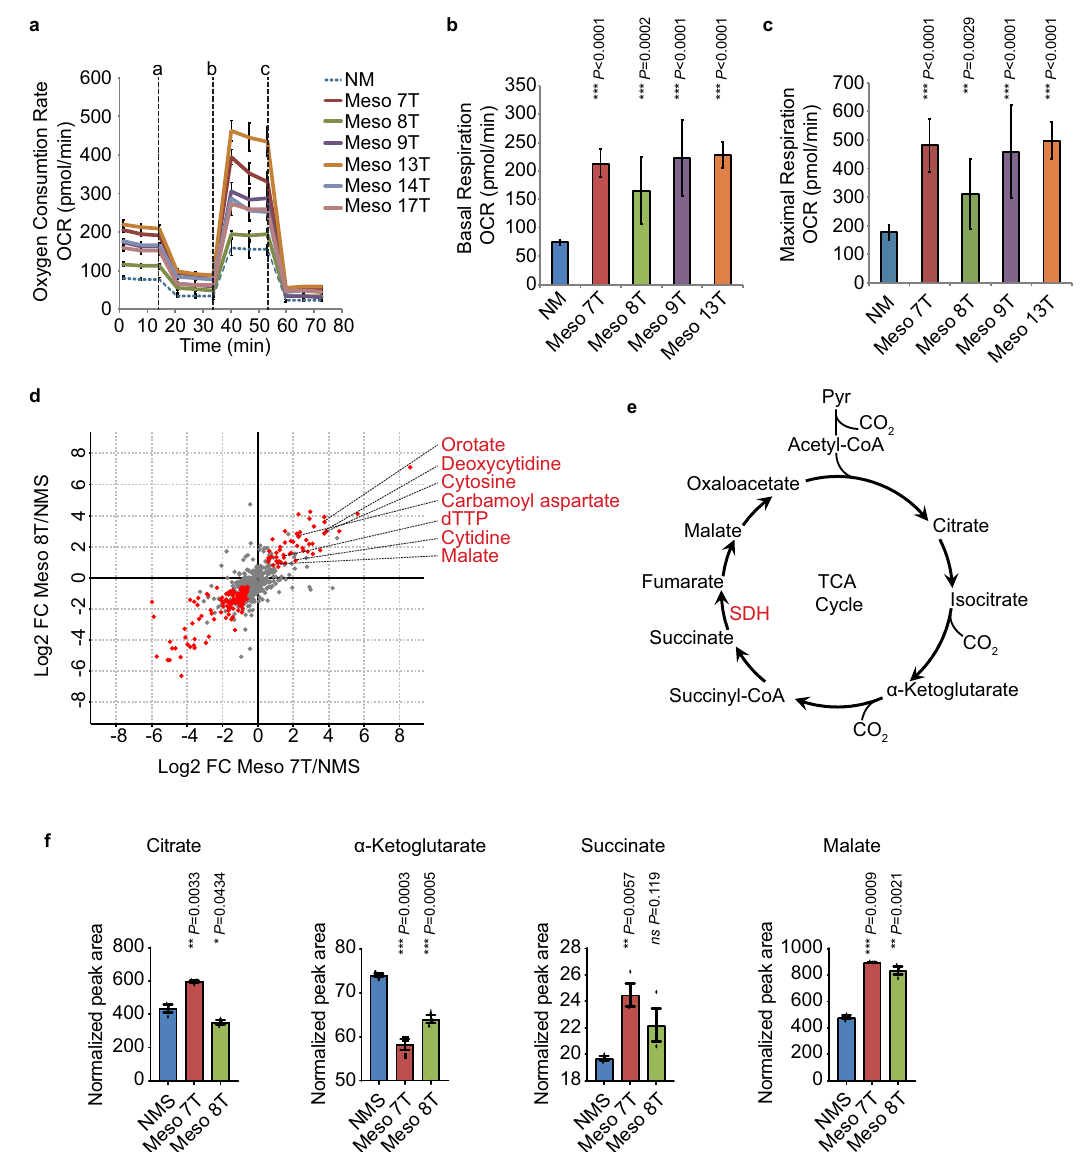
Fig. 4 Metabolic changes in MpM-derived cells. a The oxygen consumption rate (OCR) of primary MpM and NM control cells was measured in the seahorse extracellular fl ux assay. The vertical dashed lines indicate when oligomycin ( a ), FCCP ( b ) and rotenone + antimycin A ( c ) were injected. Error bars represent standard deviation and the measure of the centre of the error bars is the mean ( n = 6 where n = number of independent biological repeats of the oxygen consumption rate experiments). b The basal respiration of primary MpM and NM control cells was measured as the OCR value before oligomycin injection. Error bars represent standard deviation and the measure of the centre of the error bars is the mean. Signi fi cance was assessed using a two-tailed unpaired Student ’ s t test adjusted for multiple comparisons ( n = 6 where n = number of independent biological repeats of the basal respiration rate measurements, p values are shown on the bar graphs). c The maximal respiration of primary MpM and NM control cells was measured as the highest OCR value after FCCP injection. Error bars represent standard deviation and the centre of the error bars is the mean. Signi fi cance was assessed using unpaired two-sided student ’ s t test adjusted for multiple comparisons ( n = 6, n = number of biological repeats of maximal respiration rate measurements, p values are shown on the bar graphs). d Cell extracts were prepared from Meso 7 T, Meso 8 T and NMS cells and analysed by LC-MS/MS. Untargeted data analysis revealed increased intracellular abundance of malate, various intermediates of de novo pyrimidine synthesis, and derivatives of pyrimidine nucleotides in mesothelioma cells. Red dots indicate metabolites for which intracellular abundance was altered signi fi cantly and coherently in both cell lines compared with NMS cells (absolute log2 fold change ≥ 0.58; adjusted p value < 0.05 (Benjamini – Hochberg), ANOVA). e Schematic to show the TCA cycle. f Data analysis was performed to determine the intracellular abundance of citrate, α -ketoglutarate, succinate and malate. Data represent the mean ± SD obtained and the centre of the error bars represents the mean. Signi fi cance was assessed using two-sided unpaired two-sided student ’ s t test adjusted for multiple comparisons, p values are shown on the bar graphs. NMS = normal mesothelial cells, blue bars, Meso 7 T is red bars and Meso 8 T are the green